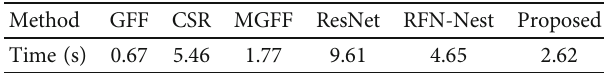
Table 4: Average running time of all methods on a pair of images of size 52 × 582